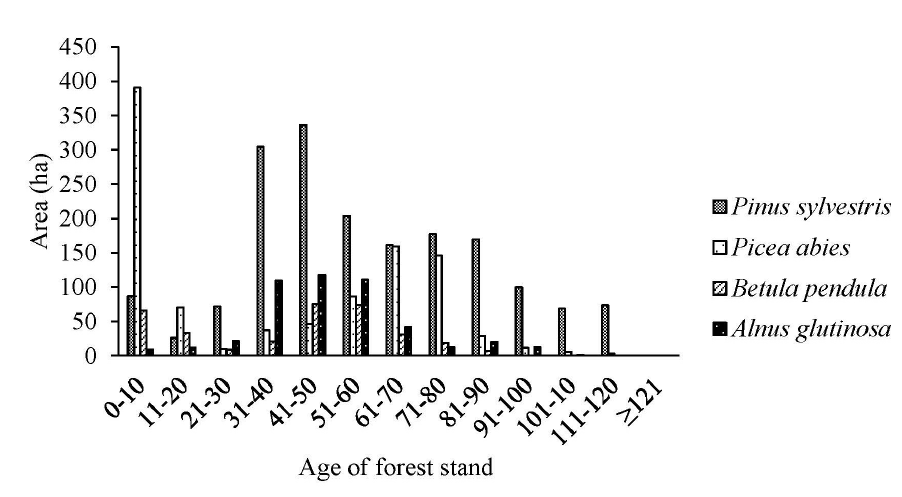
Figure 5. Distribution of Sambucus sp. according to the age of the different dominant tree in the stands (ha).